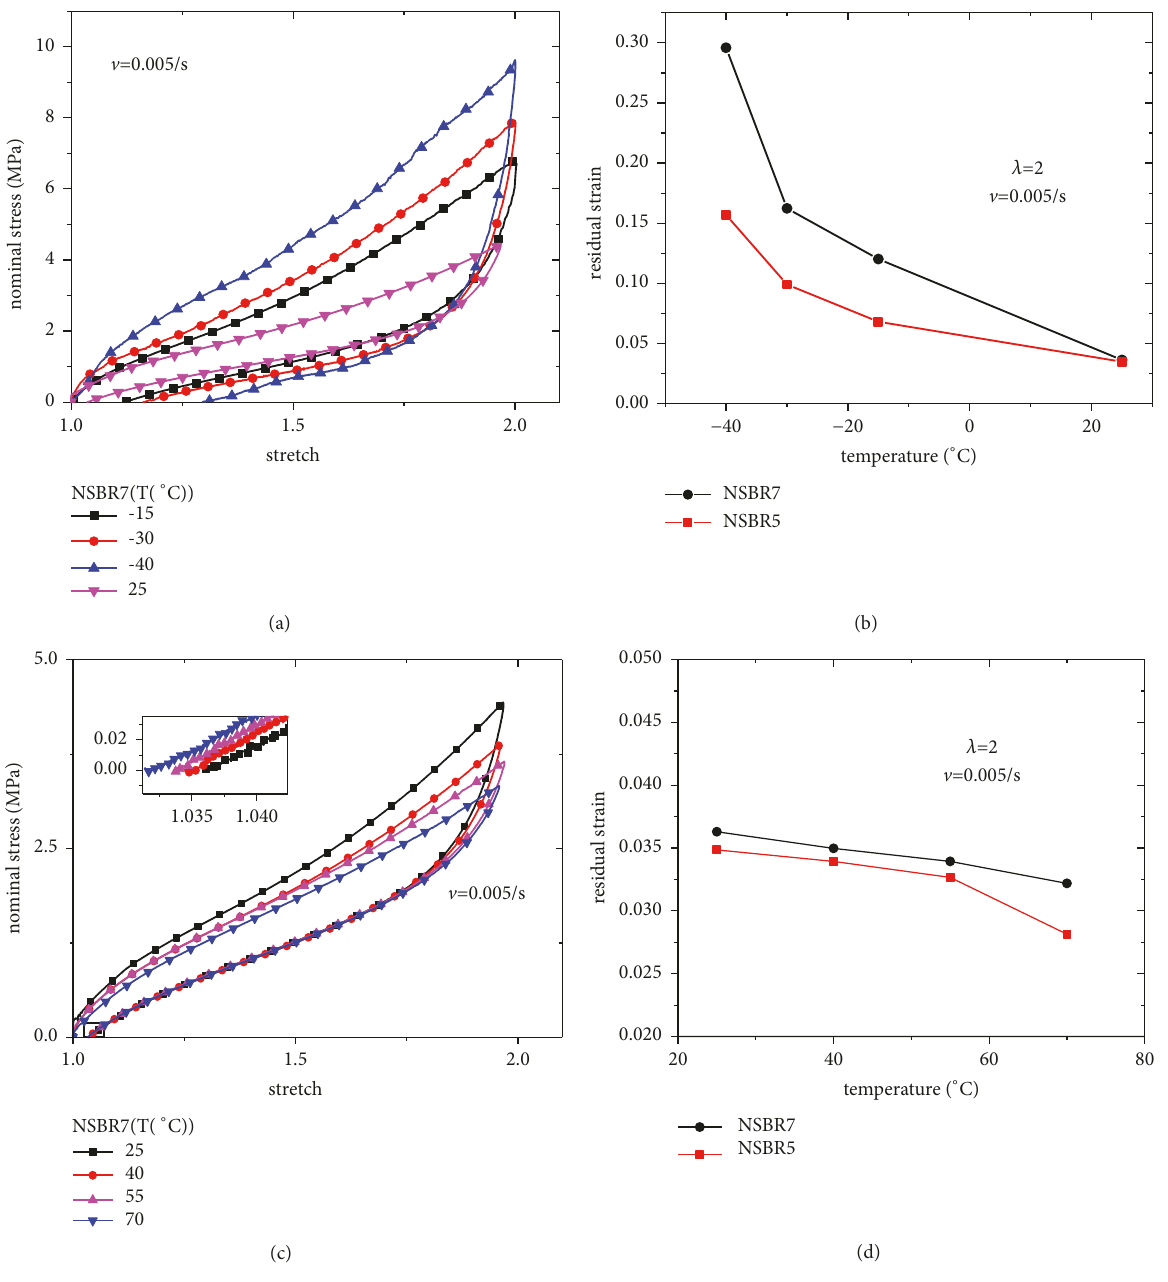
Figure 4: Curves of the residual strain and temperature of the rubber: (a) experimental results of NSBR7 for the Mullins effect at a rate of 0.005/s in the temperature range of -40–25 ∘ C; (b) the residual strain vs. the temperature of NSBR5 and NSBR7 in the temperature range of -40–25 ∘ C; (c) experimental results of NSBR7 for the Mullins effect at a rate of 0.005/s in the temperature range of 25–70 ∘ C; (d) the residual strain and temperature of NSBR5 and NSBR7 in the temperature range of 25–70 ∘ C.